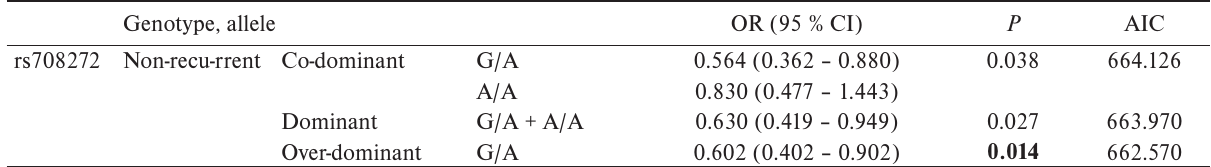
Table 4. Binomial logistic regression analysis of patients with recurrent and non-recurrent PAs and the control group. Genotype,